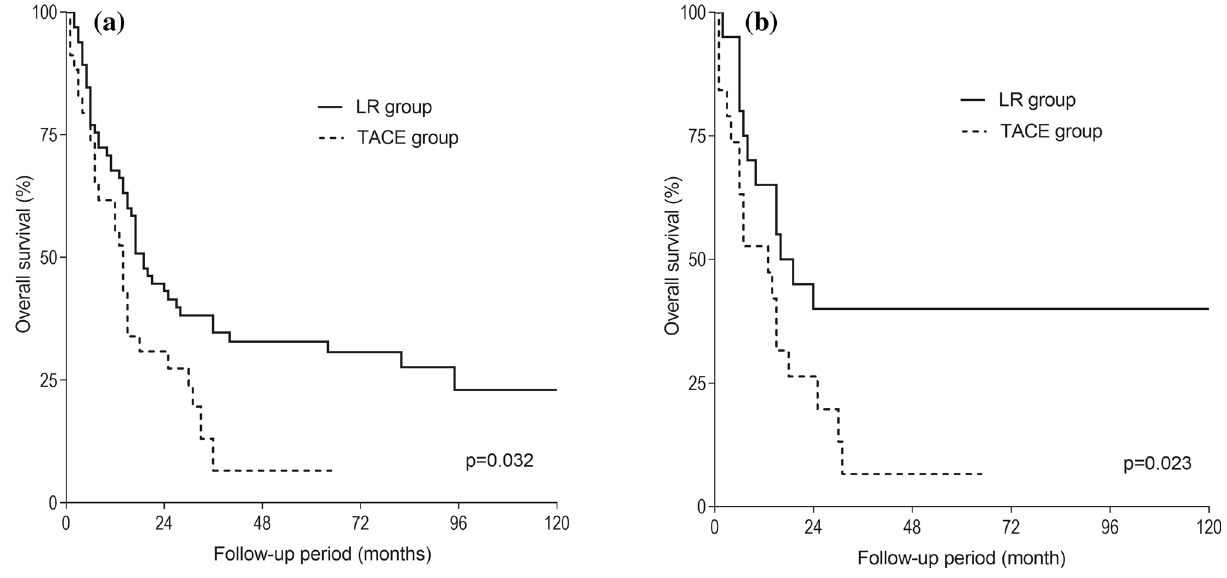
Figure 2. Overall survival curves of patients undergoing liver resection or transarterial chemoembolization before ( a ) and after ( b ) propensity match analysis. LR liver resection, TACE transarterial chemoembolization. Univariate analysis Multivariate